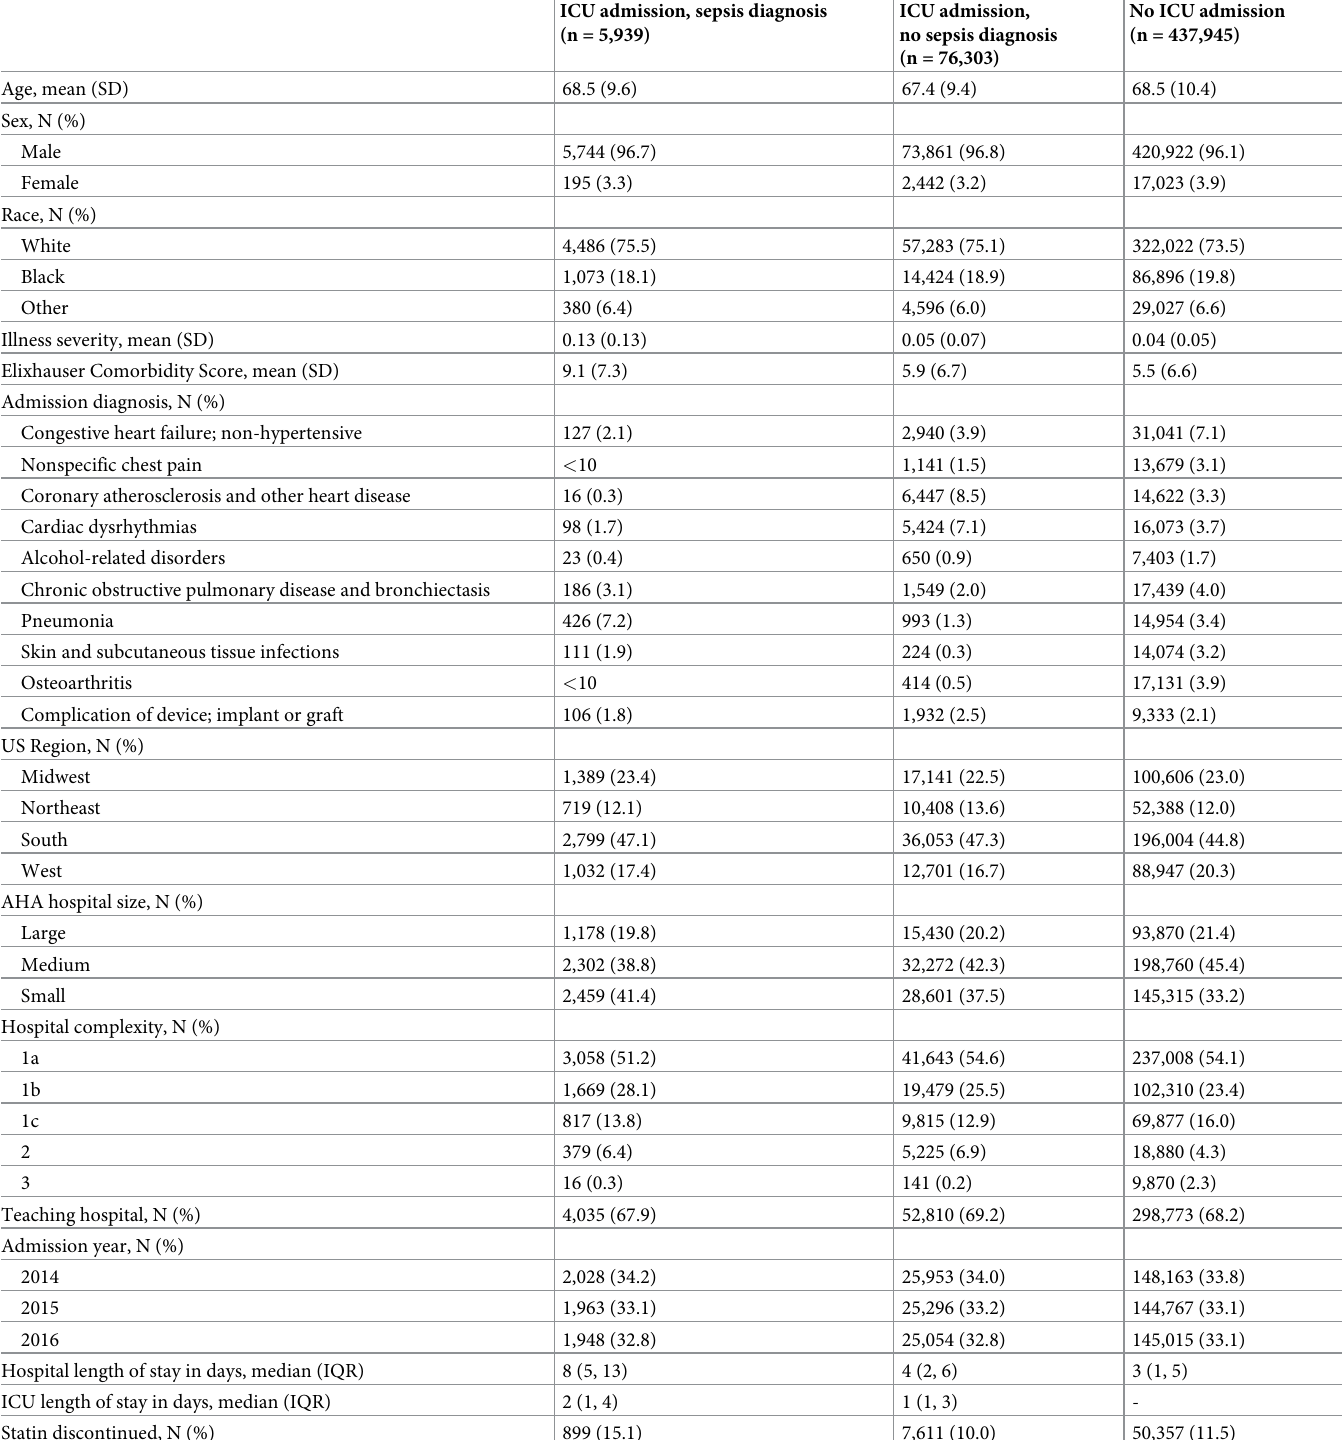
Table 1. Patient and hospital level characteristics of the statin cohort by hospitalization